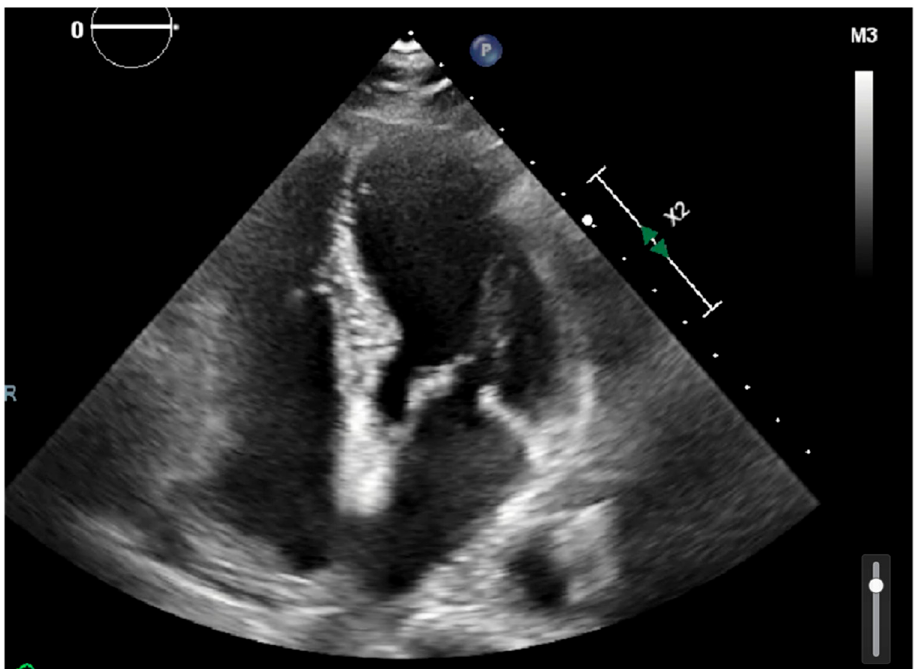
Figure 1. Echocardiography showing four-chamber view with no valvular or structural abnormalities.